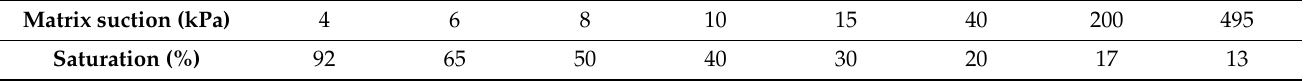
Table 2. Correspondence between matrix suction and